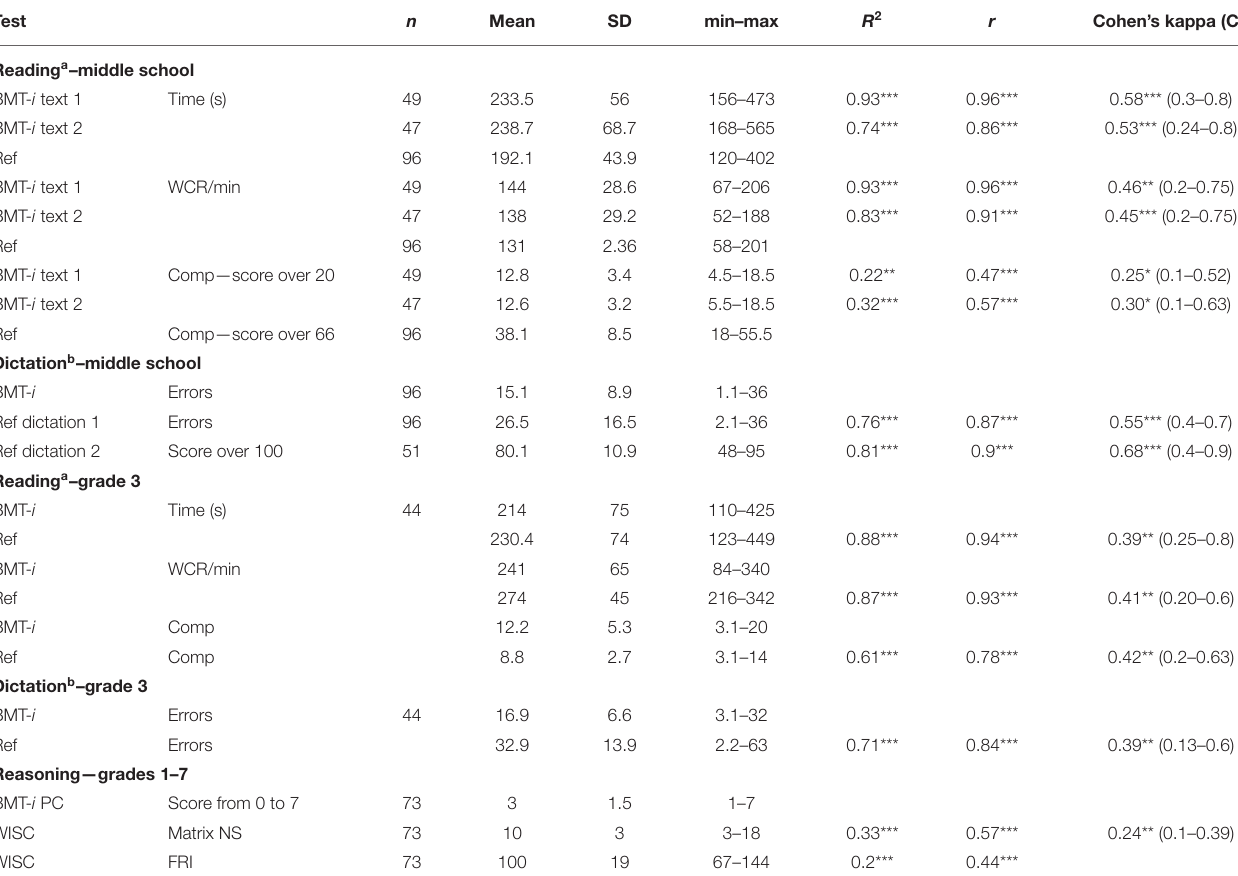
TABLE 8 | Comparison of BMT- i and reference